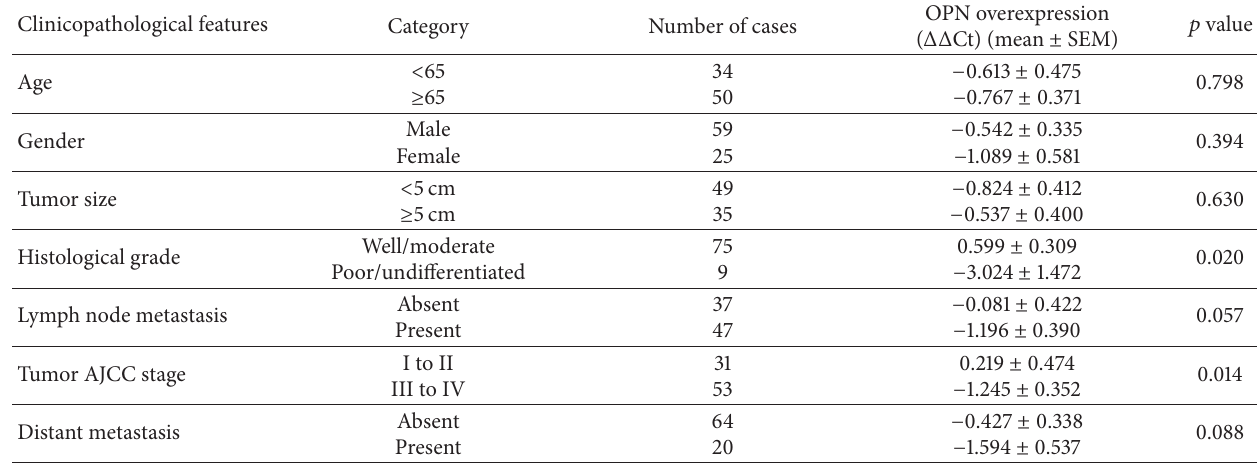
Table 1: Clinicopathological correlation of OPN overexpression in CRC ( 𝑁 = 84 ). Clinicopathological